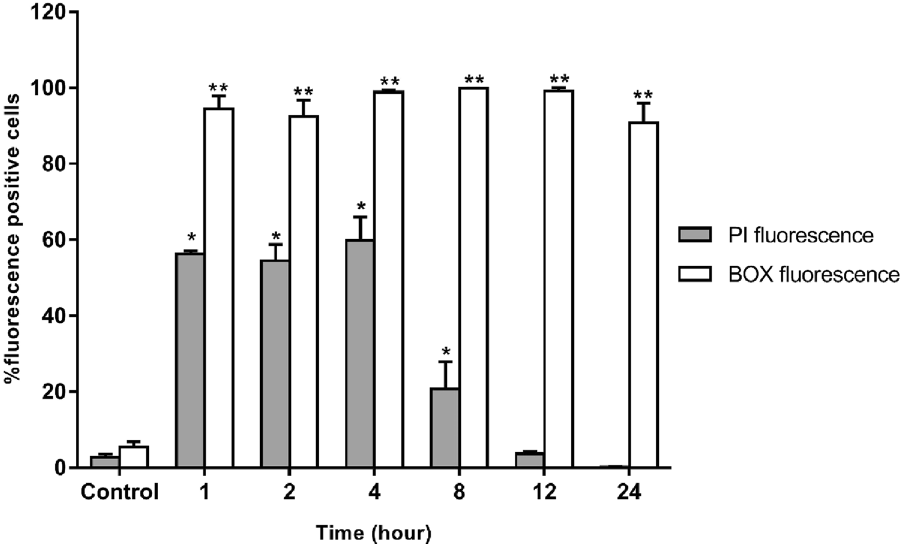
Figure 7. The effect of A11 peptide at 1 × MIC on the S . Typhimurium ATCC 13311 membrane permeability (PI) and potential (BOX) after 1, 2, 4, 8, 12 and 24 h of incubation as evaluated by flow cytometry. The tests were assessed in three independent experiments and the results were displayed as the mean and standard deviation. The statistical analysis was performed using two-way ANOVA and Tukey’s test (p < 0.05). An asterisk (*) indicates a statistically significant difference when compared to that of A11-untreated group stained with PI. The double asterisk (**) indicates a statistically significant difference when compared to that of A11-untreated group stained with BOX.